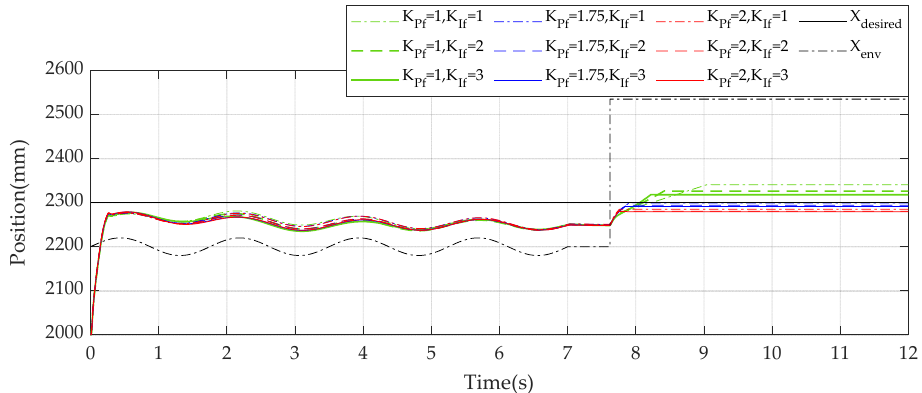
Figure 13. Response of the end-effector in the X-direction in the case of friction under different force control gains.